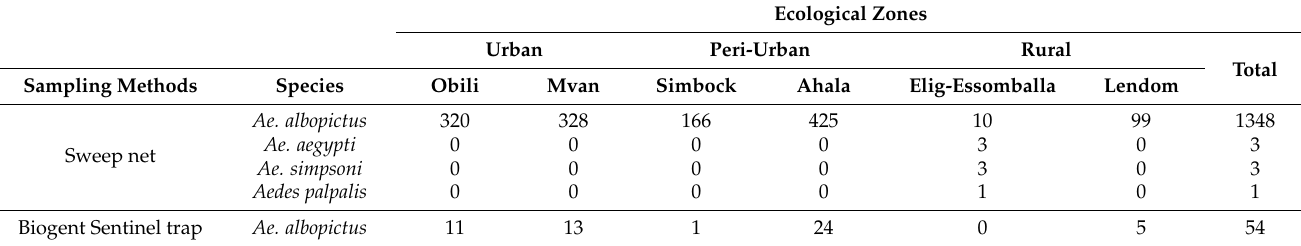
Table 5. Distribution of adult Aedes species collected using sweep nets and Biogent sentinel